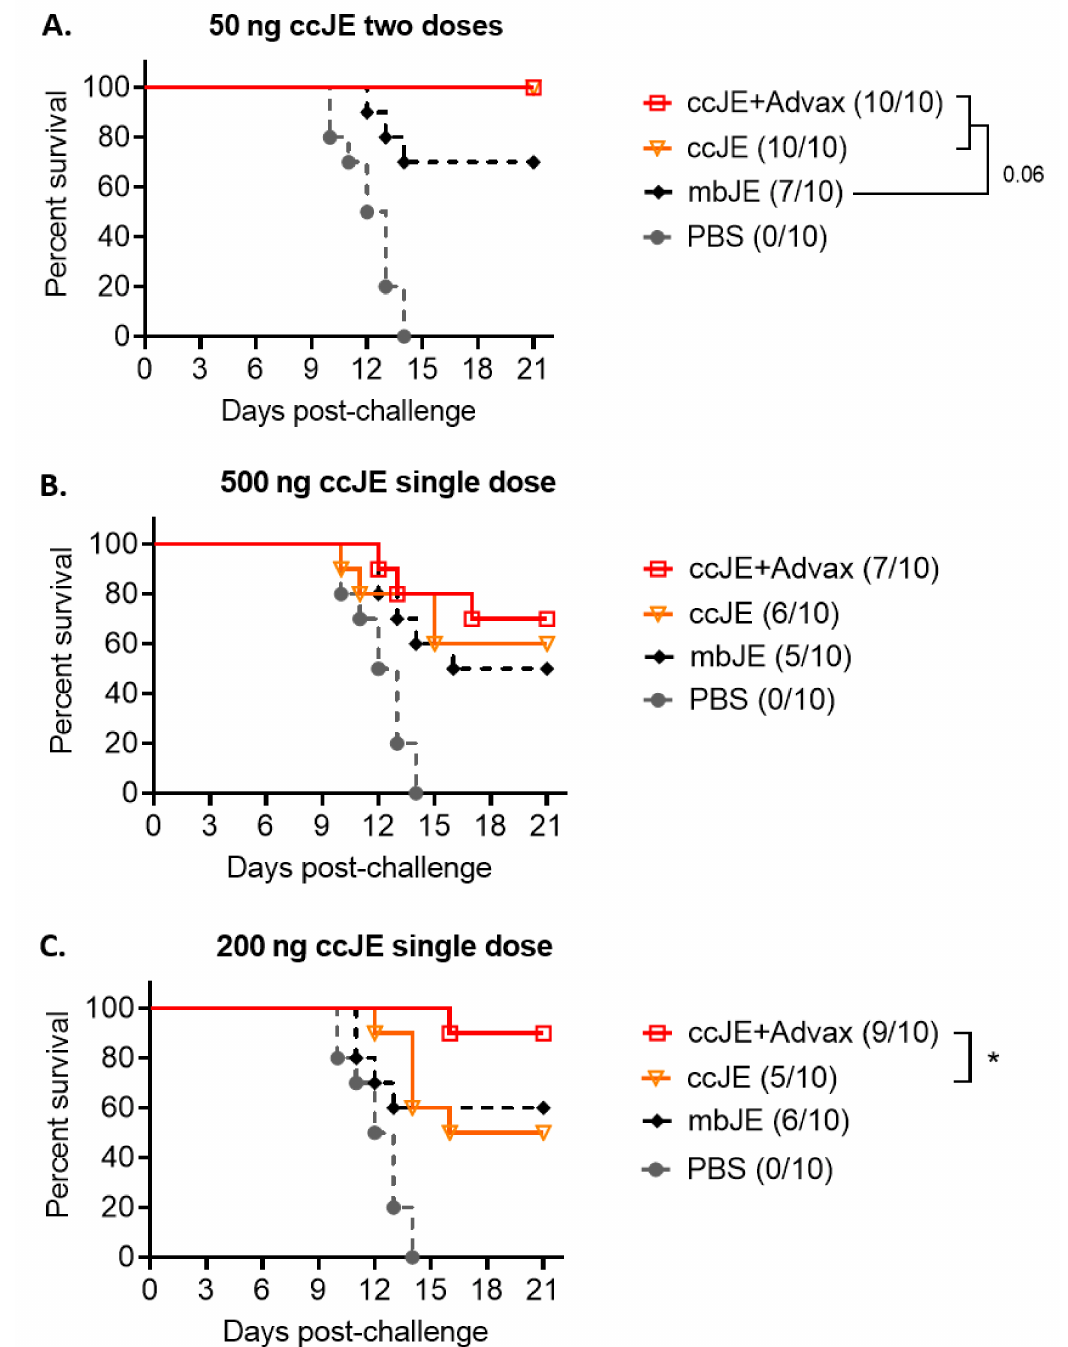
Figure 3. Advax adjuvanted ccJE vaccine provides robust protection against JEV. Four-week-old C57BL/6 mice ( n = 10/group) were immunised intramuscularly with ccJE alone or with Advax (1 mg) ( A ) twice, 1 week apart, with a vaccine antigen dose of 50 ng or once with a vaccine antigen dose of ( B ) 500 ng or ( C ) 200 ng. As a control, mice were also immunised mbJE or PBS. One week after the last immunisation, mice were challenged intraperitoneally with 3 × 10 2 PFU JEV JaTH160 strain. Survival rate (number of survivors/number of challenged mice shown in parenthesis, * p < 0.05 by log-rank Mantel-Cox